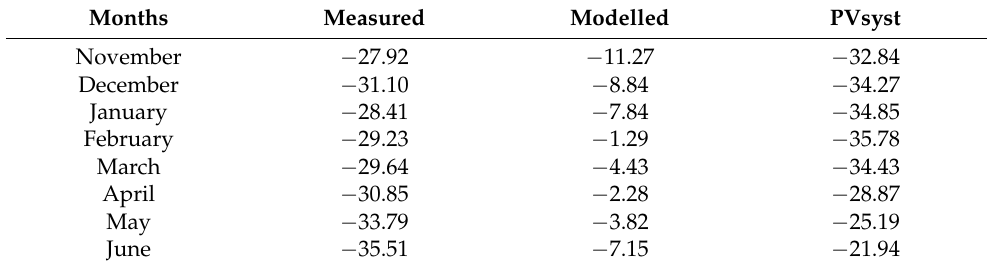
Table 8. Monthly vertical bifacial PV loss over monofacial PV